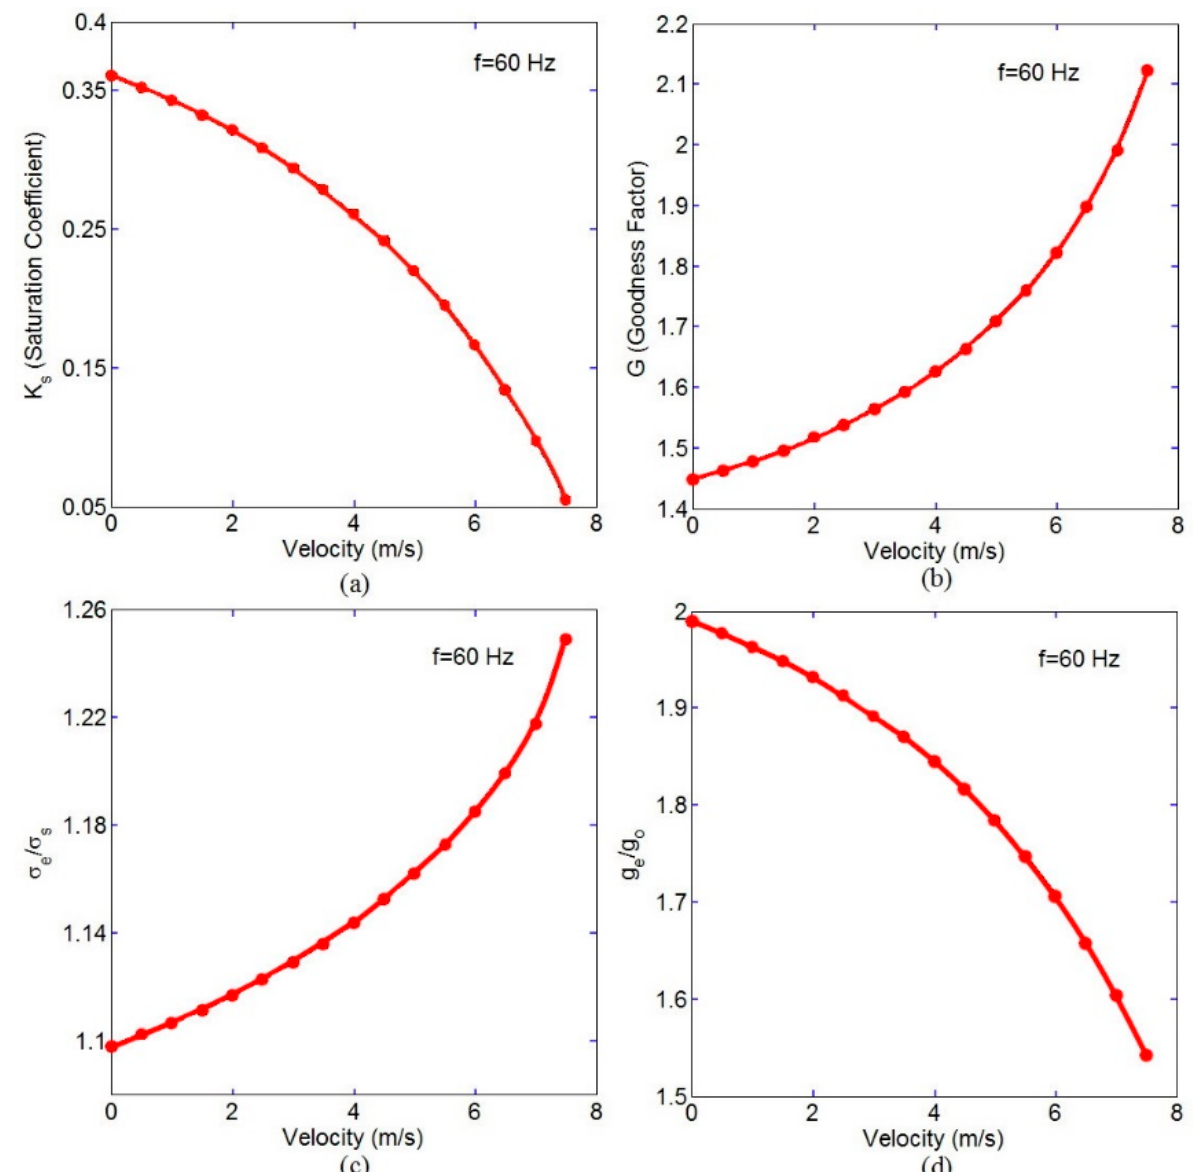
Figure 5. Field analysis results versus the velocity: ( a ) saturation coefficient ( b ) goodness factor ( c ) ratio of the secondary equivalent conductivity to the nominal conductivity, and ( d ) ratio of the equivalent air-gap length to the nominal air-gap length.